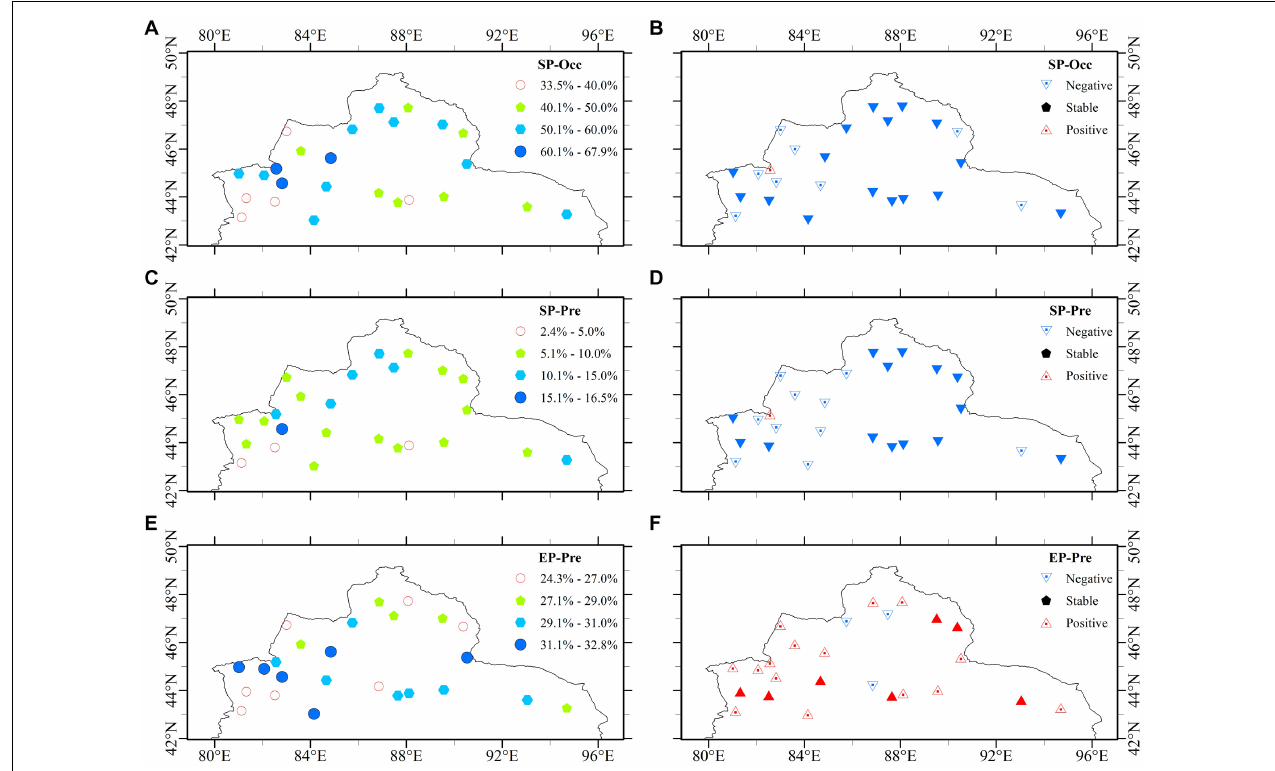
FIGURE 3 | (A) The average contribution of SP events to the total annual number of wet days, (B) linear trends in the contribution of SP events to the total annual number of wet days over 55 years, (C) the contribution of SP events to the total annual precipitation amount, (D) linear trends in the contribution of SP events to the total annual precipitation amount over 55 years, (E) the contribution of EP events to the total annual precipitation amount, and (F) linear trends in the contribution of EP events to the total annual precipitation amount over 55 years. Solid triangles mark where the linear trends are significant at the 95% confidence